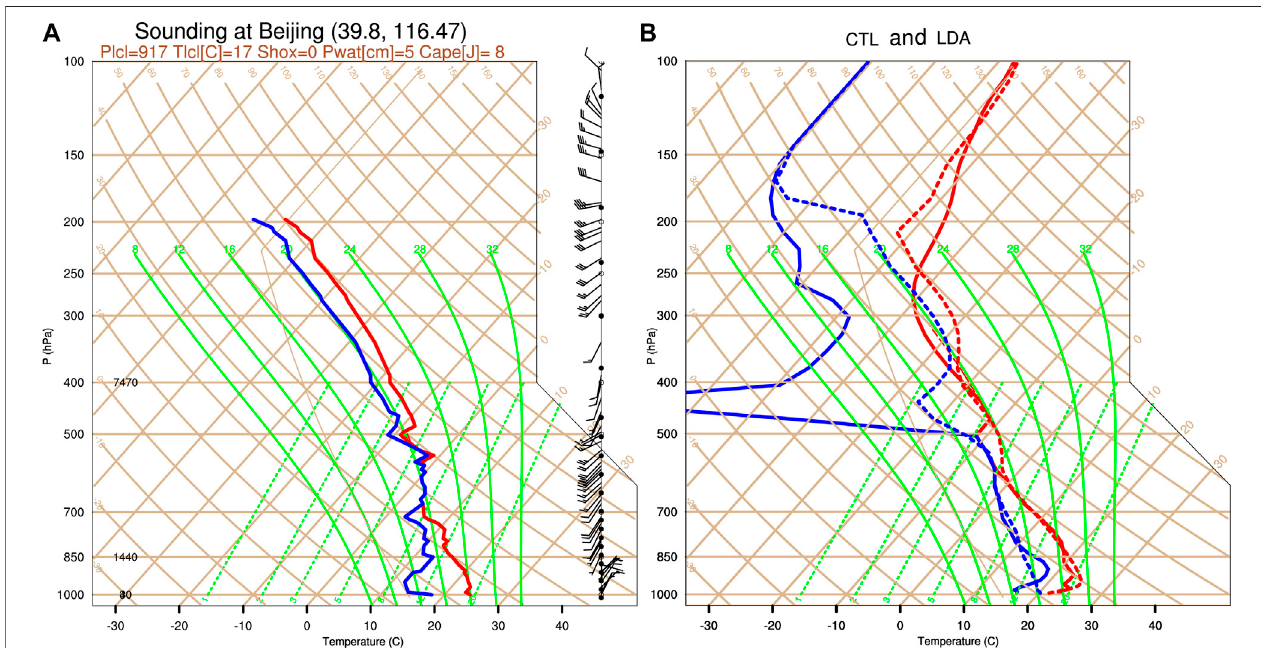
FIGURE7| Comparisonof in-situ soundingsat1200UTC9Augustbetween (A) observationsand (B) simulations.Thesolidanddashlinesinpanel (B) represents control experiment and assimilation experiment, respectively.